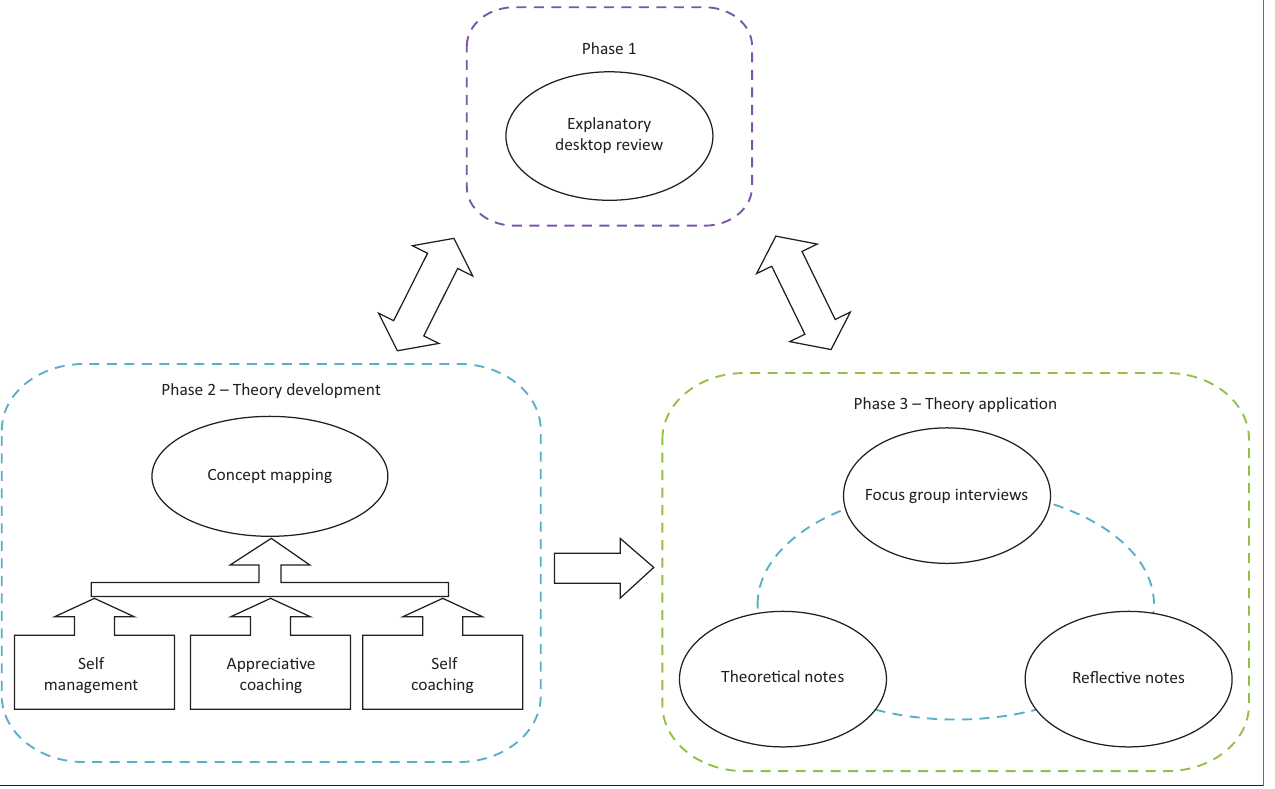
FIGURE 1: Schematic representation of the study phases.